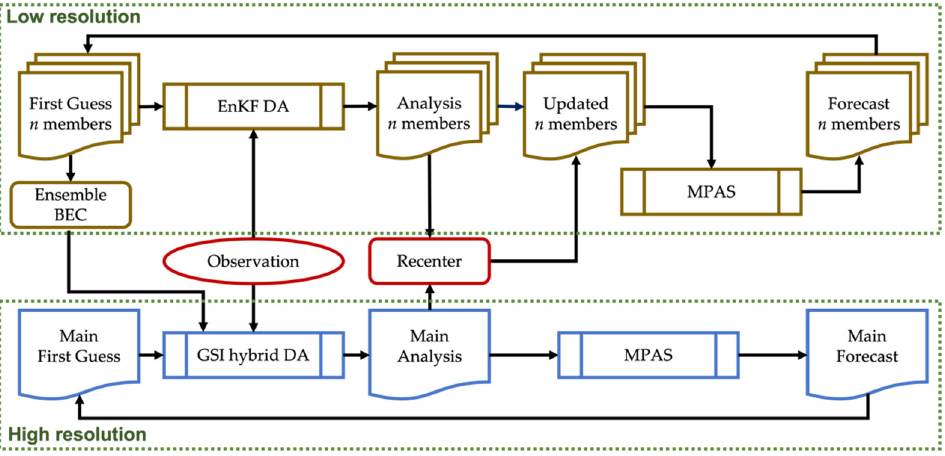
Figure 1. The flowchart of the GSI hybrid data assimilation. The data assimilation is divided into two parts that include the EnKF and GSI systems. The EnKF system uses n members ( n is 36 in this study) at the lower resolution to provide background error covariances for the GSI system. The GSI system at the higher resolution provides the analysis for the EnKF system to re-center all ensemble members with the coarser resolution for MPAS forecasts, and then the new ensemble members can be updated for use in the next cycling.